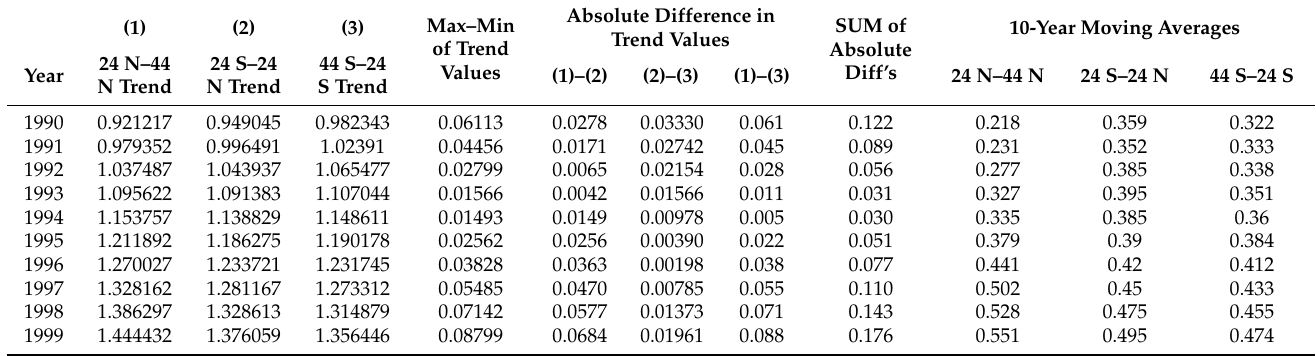
Table 4. Characteristics of the linear trends and 10-year moving averages for the coffee-producing